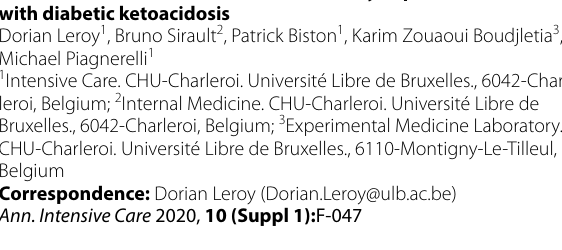
Fig. 1 Example of heat map about expression of miRNAs in selection of ARDS population (8) vs healthy subjects (8) F‑047 Assessment of red blood cell deformability in patients